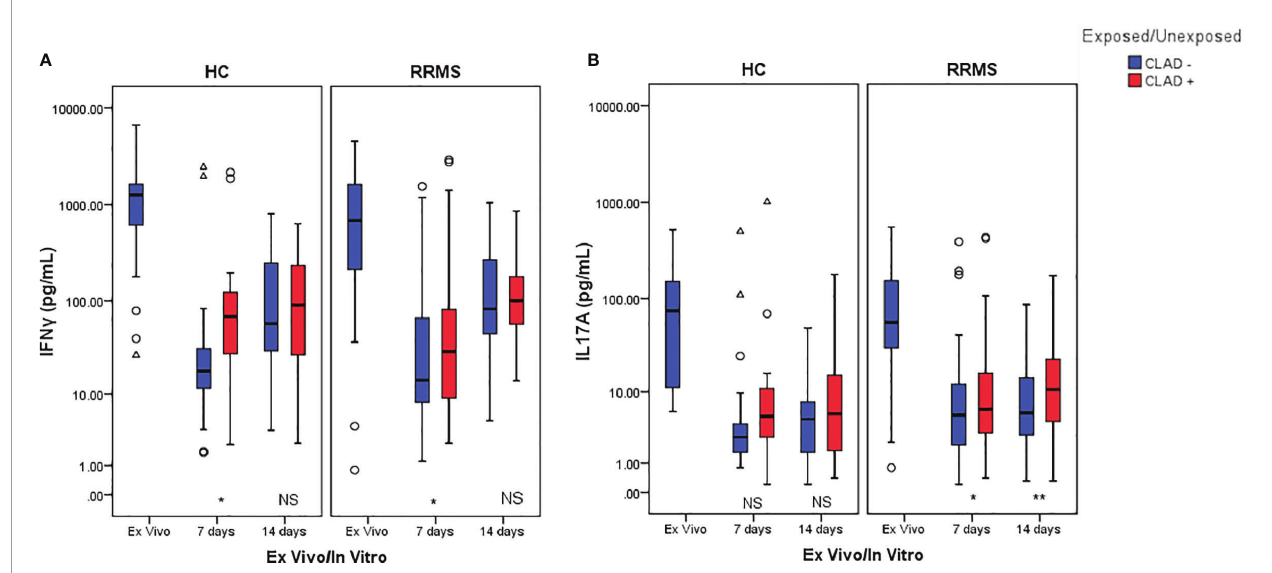
FIGURE 10 | Changes in IFN g (A) and IL17 (B) secretion pro fi les after cladribine exposure represented as boxplot (median with error bars). NS, non signi fi cant (p > 0.05) P -values were considered signi fi cant when lower than 0.05 (* p ≤ 0.05, ** p ≤ 0.01).